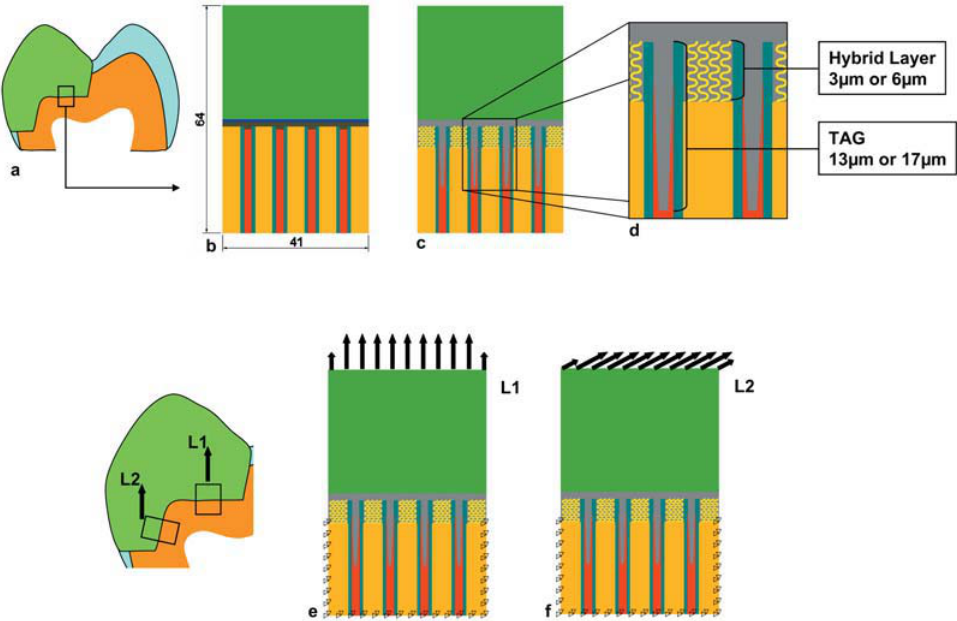
FIGURE 1- (a and b) Dentin specimen (orange) restored with composite resin (green) (dimensions in µm). (c) Specimen with hybrid layer (HL). (d) Variation of HL thickness (3 to 6µm) and resin TAG length (13 to 17µm) – collagen (yellow), adhesive dentin and resin TAG (grey), peritubular dentin (dark green) and intertubular dentin (orange) (e) Perpendicular loading (L1). (f) Oblique loading